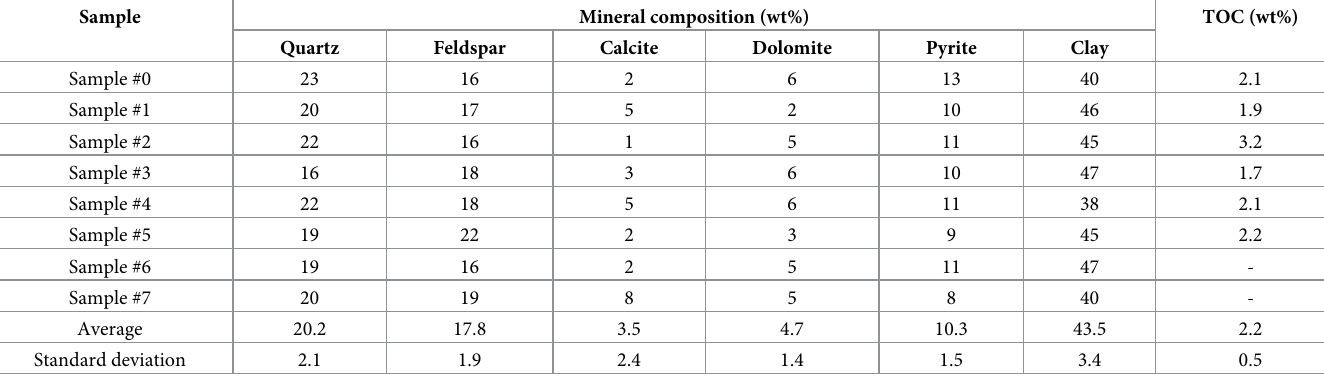
Table 1. Mineral compositions and organic content of the marine shale samples used in this